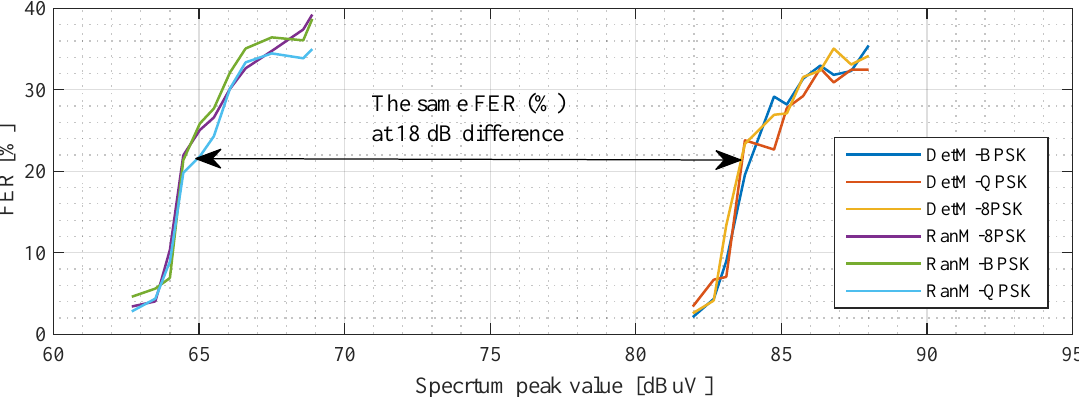
Figure 10. FER Vs Magnitude in dBuV for different PLC modulation schemes in case of DetM and